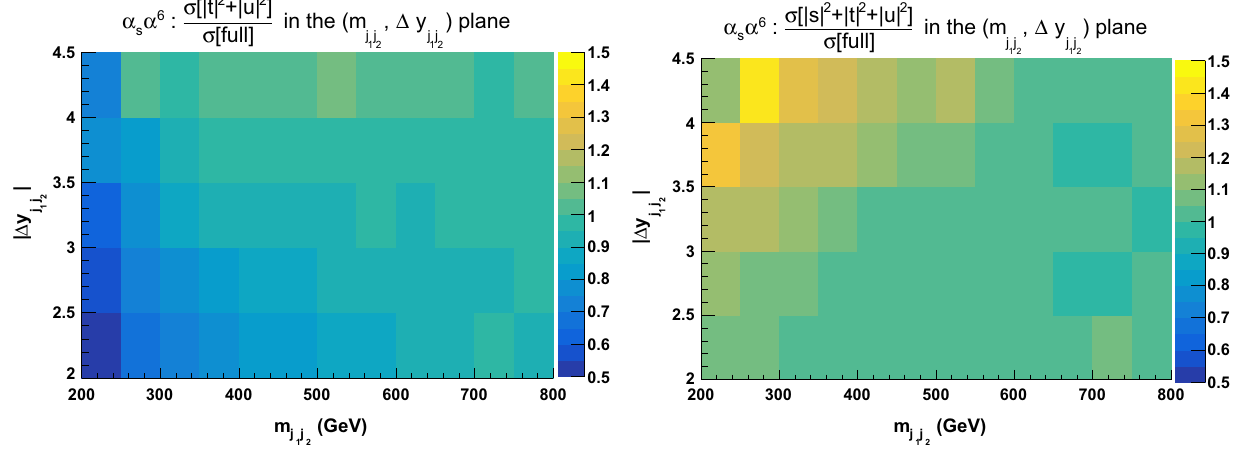
Fig. 7 Ratios for double-differential distributions in the variables m jj and | Δ y jj | at NLO QCD i.e. at order O (α s α 6 ) of the approximated squared amplitudes over the full matrix element. The approximated